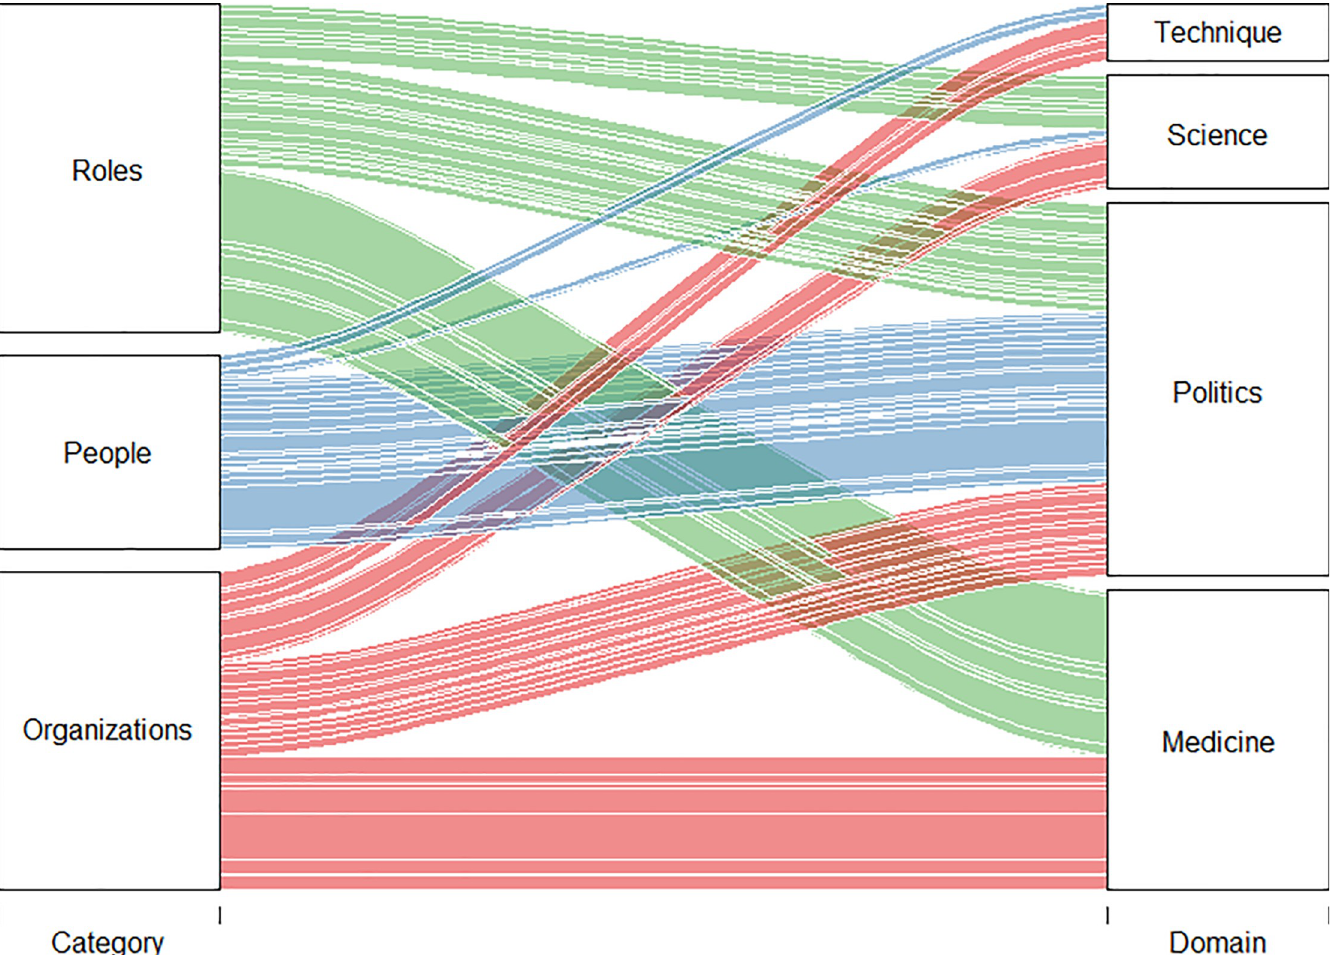
Fig 6. Named entities (n = 82) distributed by category, domain of expertise, and mutual relationships.